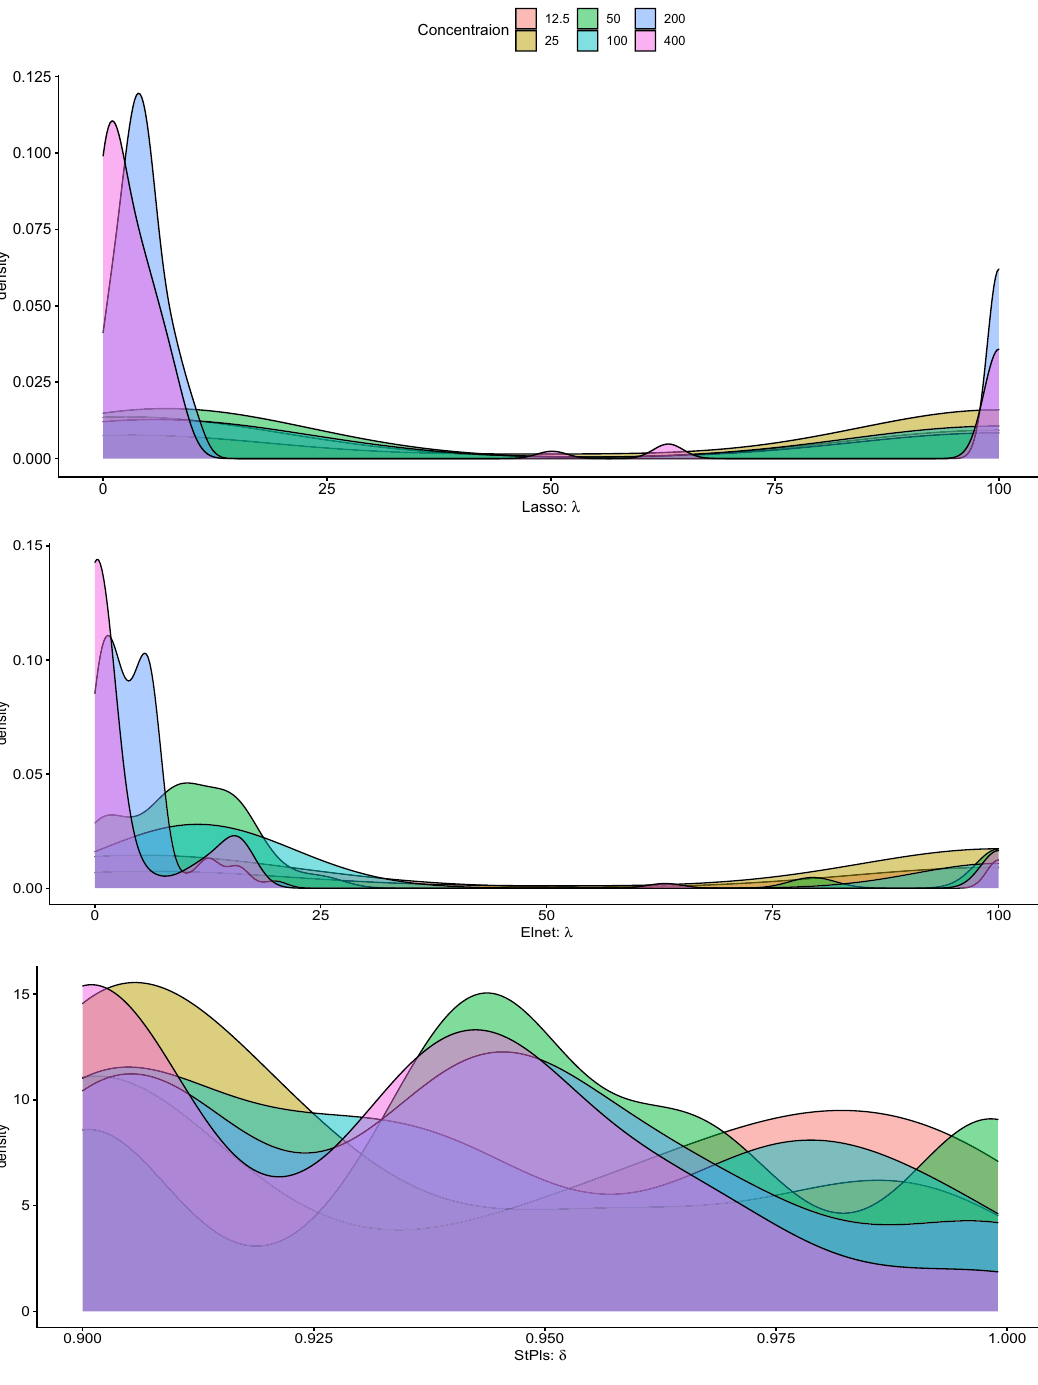
Figure 3. A comparison of the parameters of the fitted model is